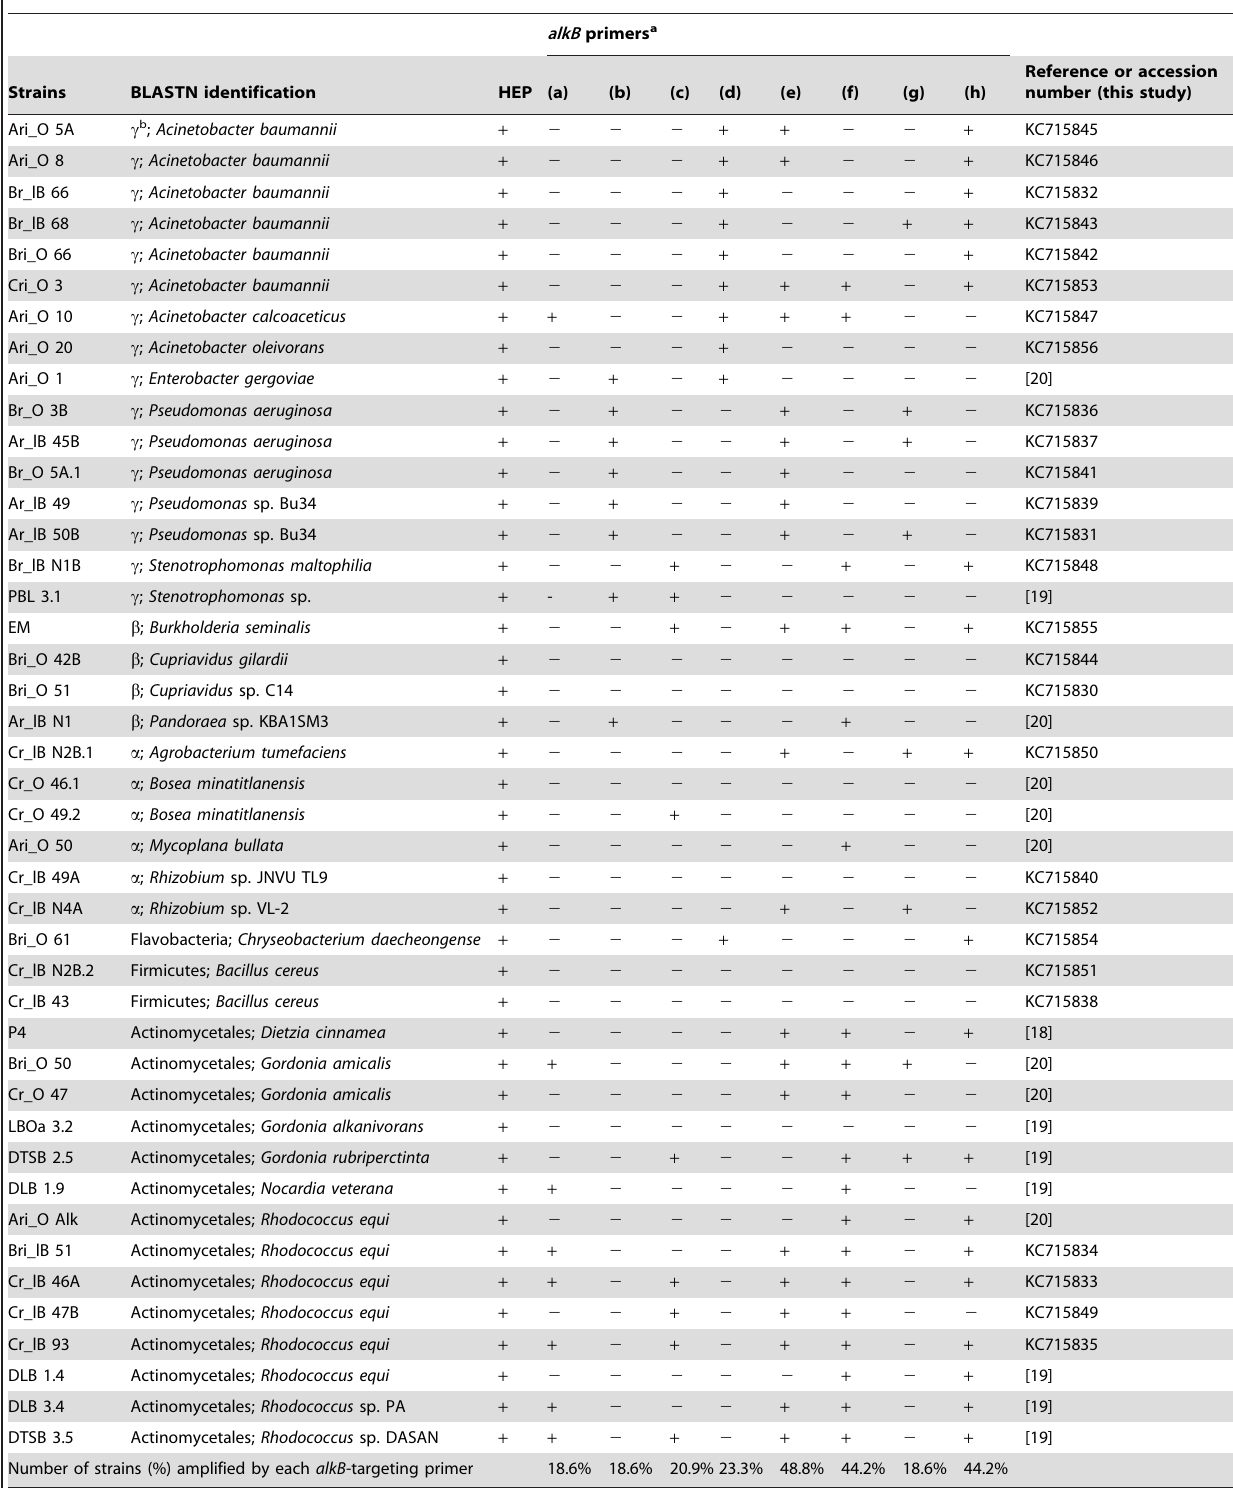
Table 2. PCR amplification of the alkB gene from alkane-degrading bacterial strains using different alkB -targeting